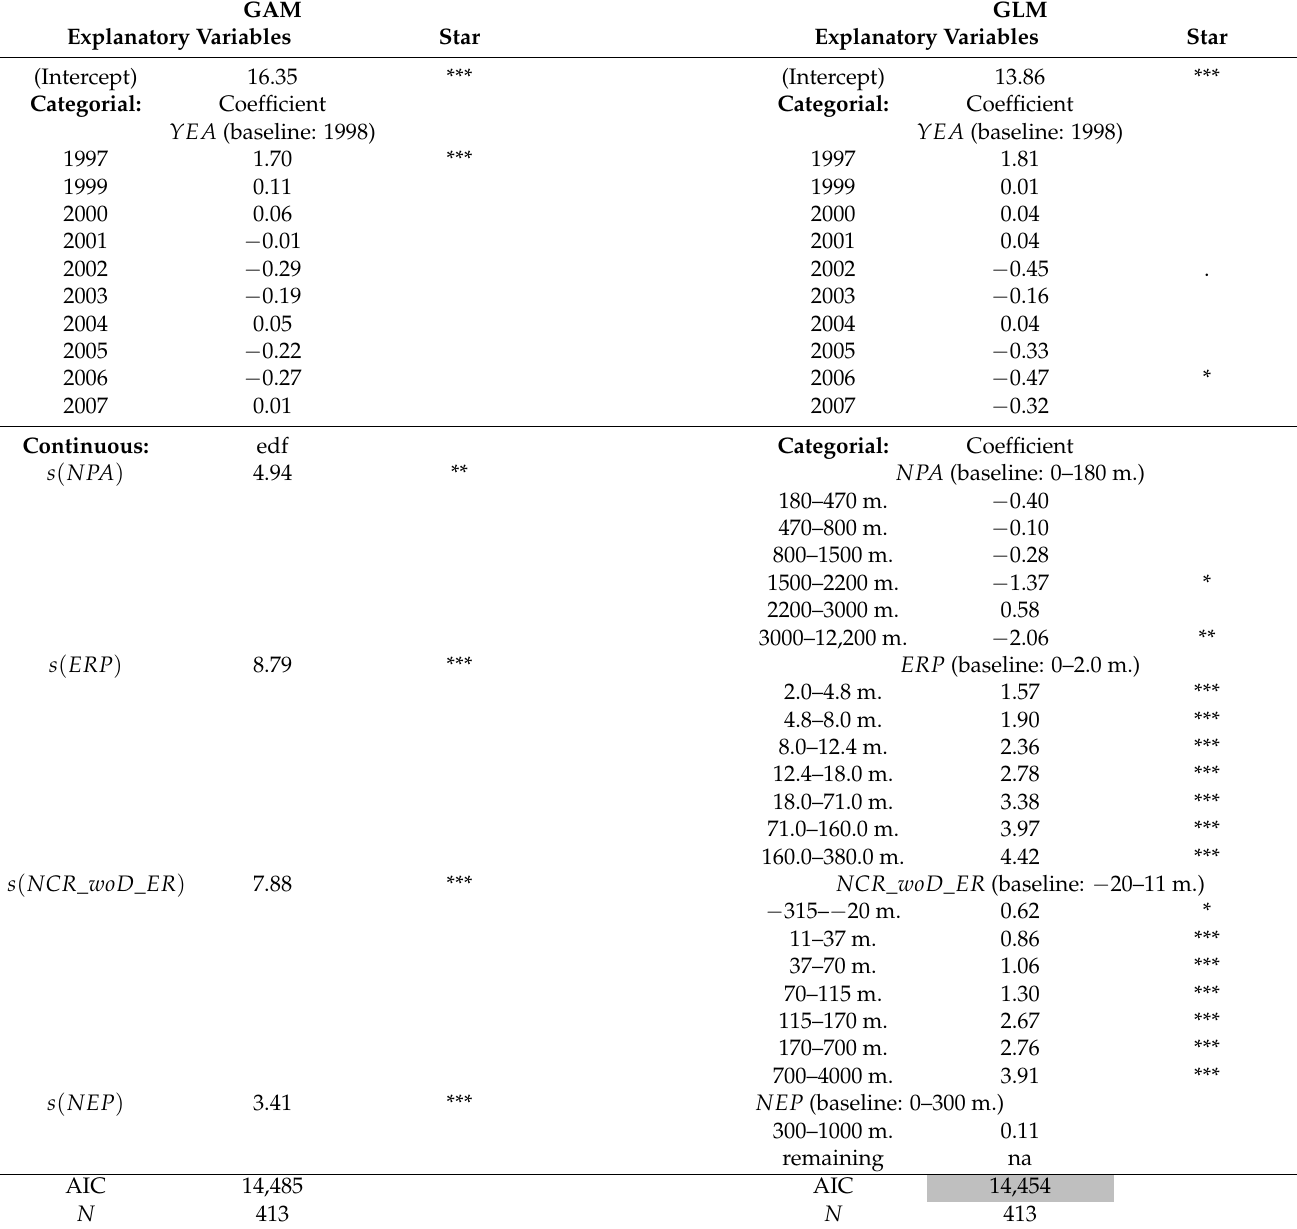
Table 10. Output of the GAM and GLM for non-life